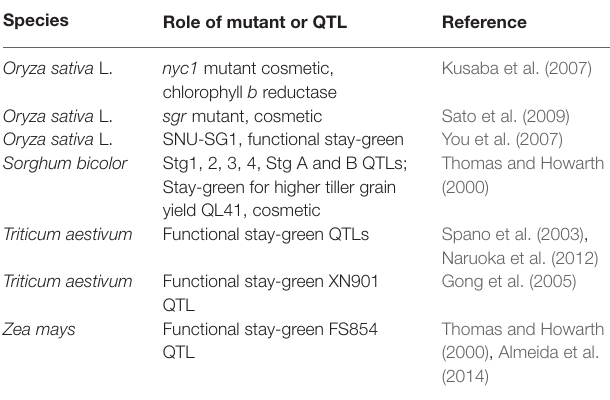
TABLE 1 | List of stay-green mutants and QTLs identified in different cereal species.